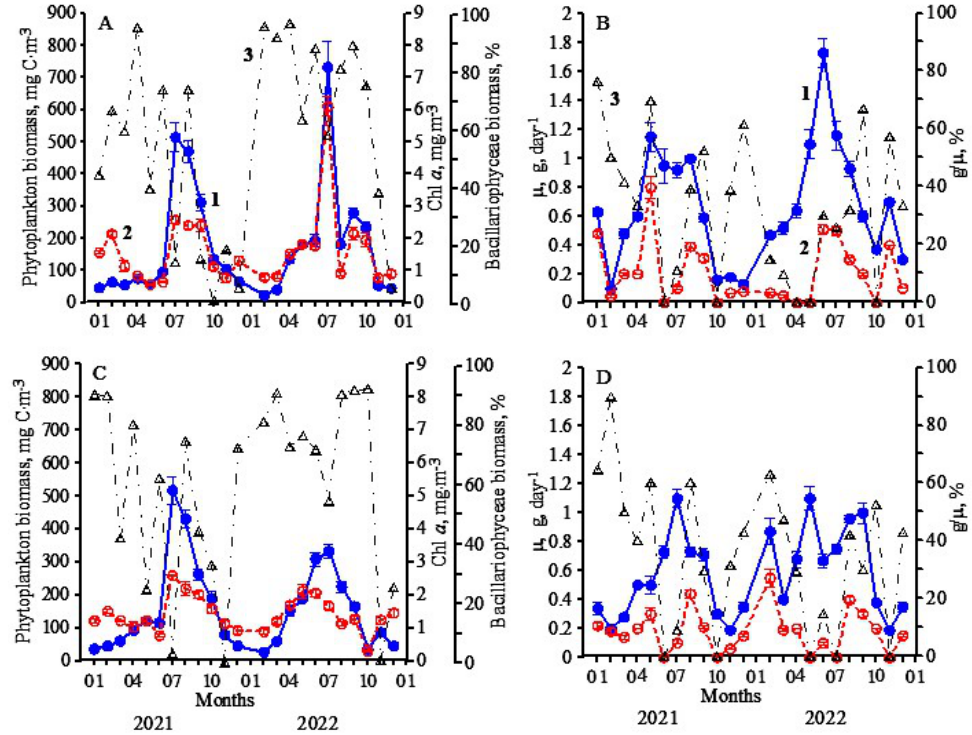
Figure 2. Seasonal dynamics of phytoplankton, its growth rate and microzooplankton grazing: ( A , C )—biomass (1–blue), chlorophyll a concentration (2–red), the relative biomass of diatoms (3–black); ( B , D )—growth rate, µ (1), microzooplankton grazing, g (2), ratio g/µ (3) in Station 1 ( A , B ) and Station 2 ( C , D ).